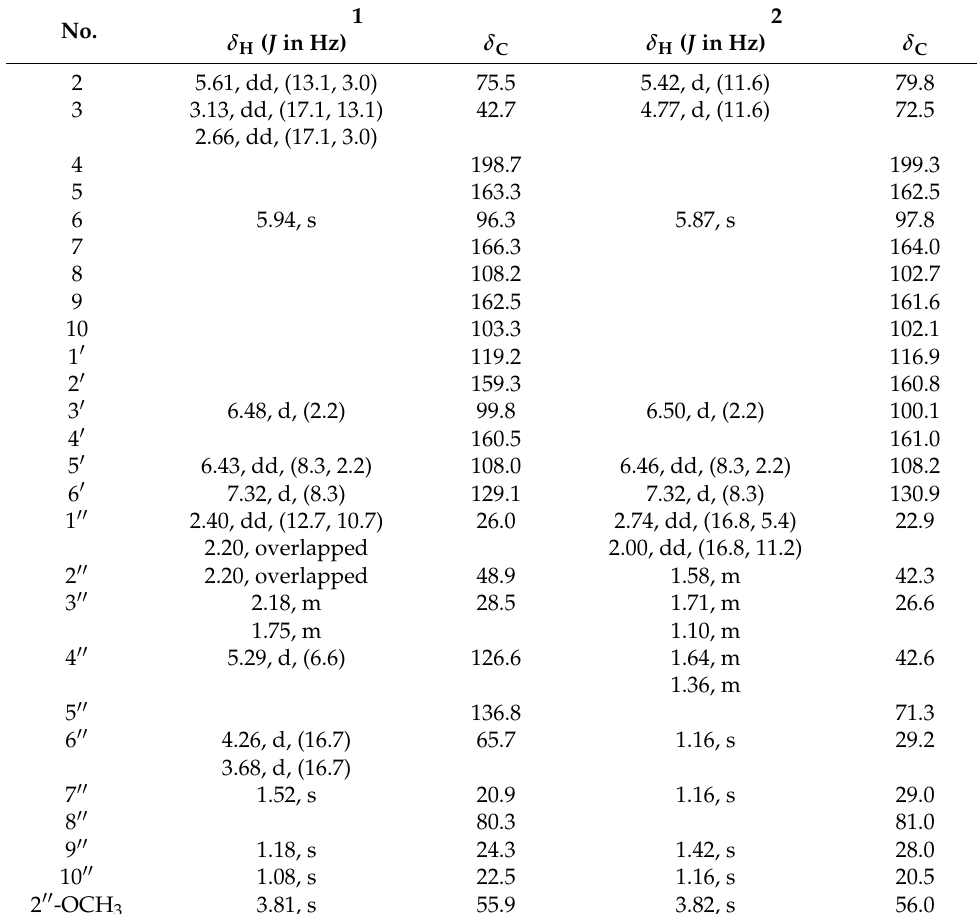
Table 1. 1 H and 13 C NMR data ( δ ) for 1 and 2 (600, 150 MHz) in MeOD- d 4 .